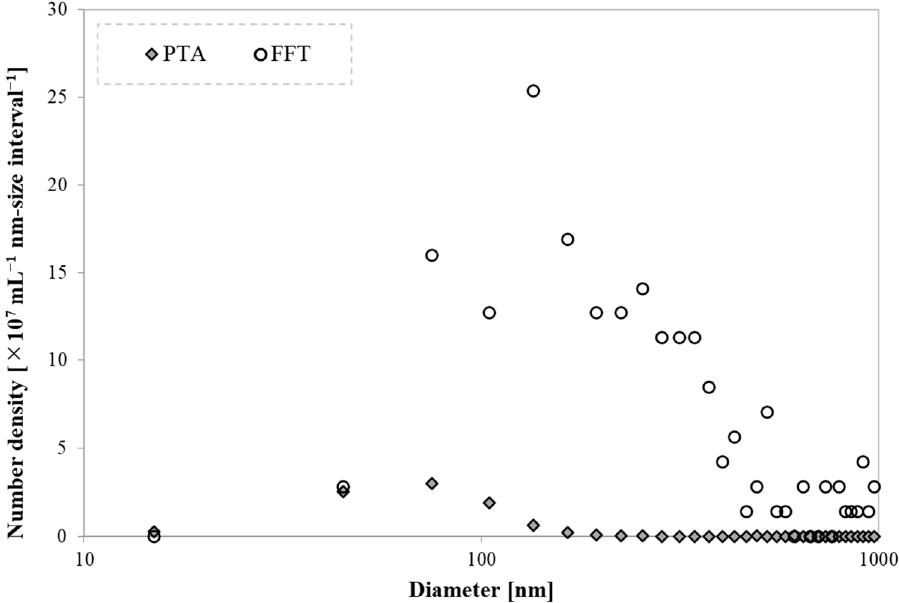
Figure 2. CO 2 UFB distributions in hydrate dissociated water. Table 1. Average diameter D and number density N of UFBs in each liquid sample.